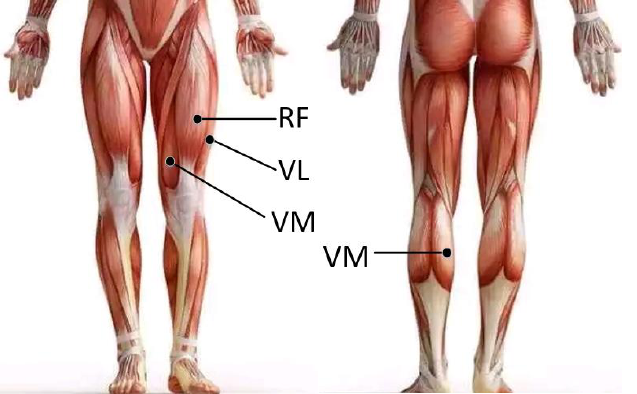
Figure 1. Description of muscle location on the left leg and sEMG electrode placement; GA, RF, VM, and VL muscles.